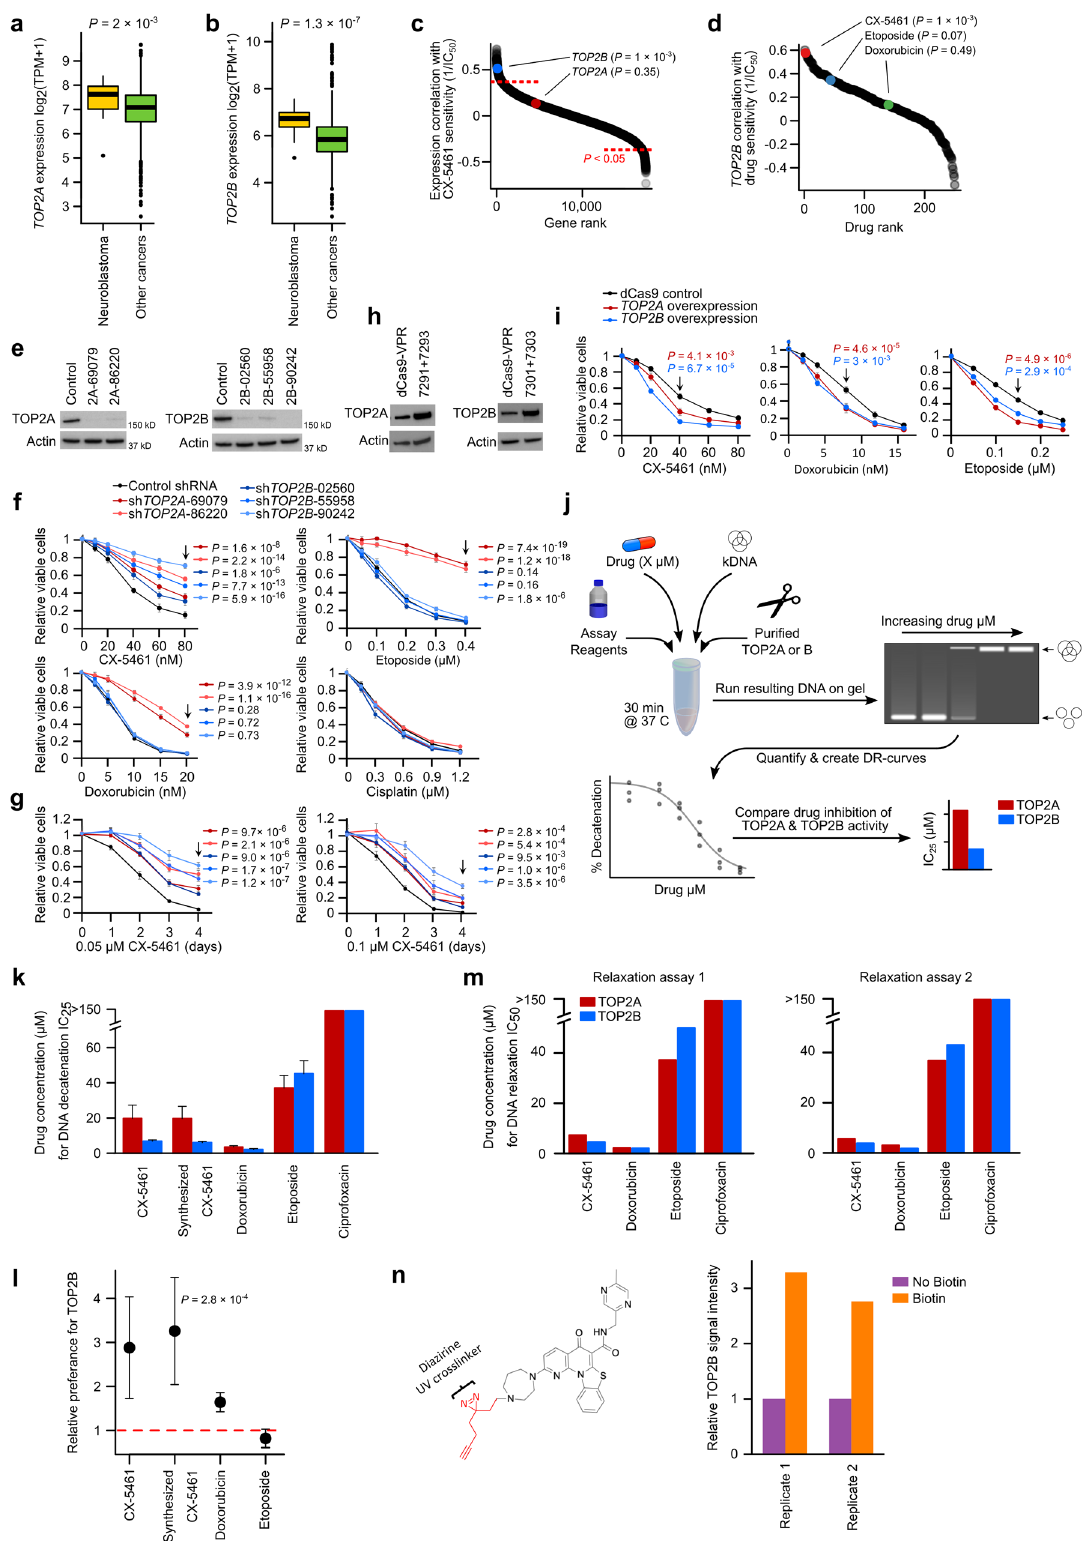
data also showed that MYCN is bound to the TOP2B promoter (Fig. S5D), consistent with the causal relationship between CX- 5461 IC 50 and MYCN expression that we observed in cell lines (Fig. 1F). Notably, MYCN and TOP2B expression were also correlated in the cell line data ( r = 0.59, P = 8.1 × 10 − 4 , n = 29) and both were associated with CX-5461 IC 50 . However, when